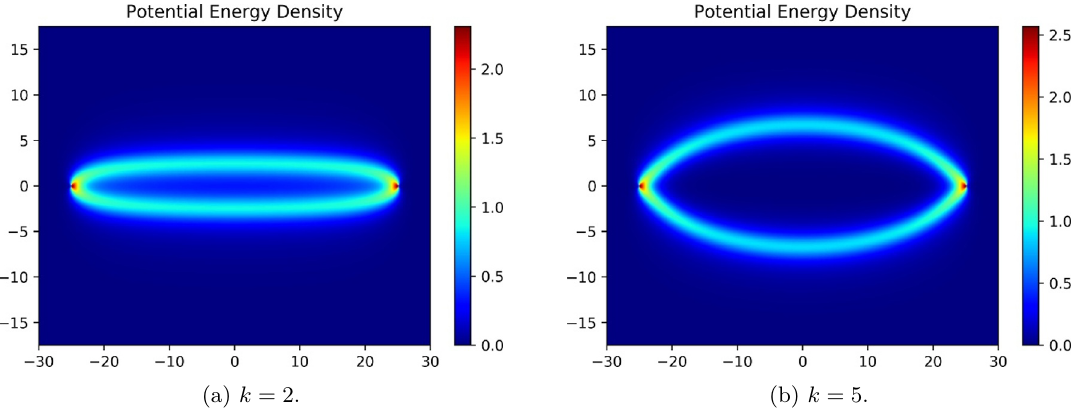
Figure 14. N -ality dependence of string separation. In SU(10) , the string separation is significantly larger for k = 5 than k = 2 (compared at the same R , of